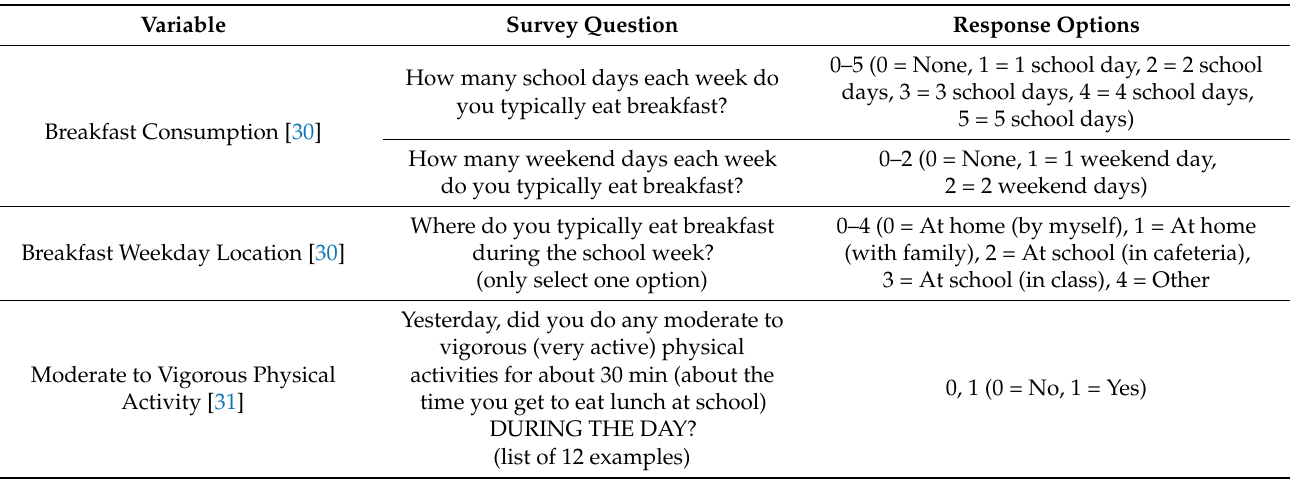
Table 1. Key survey variables of